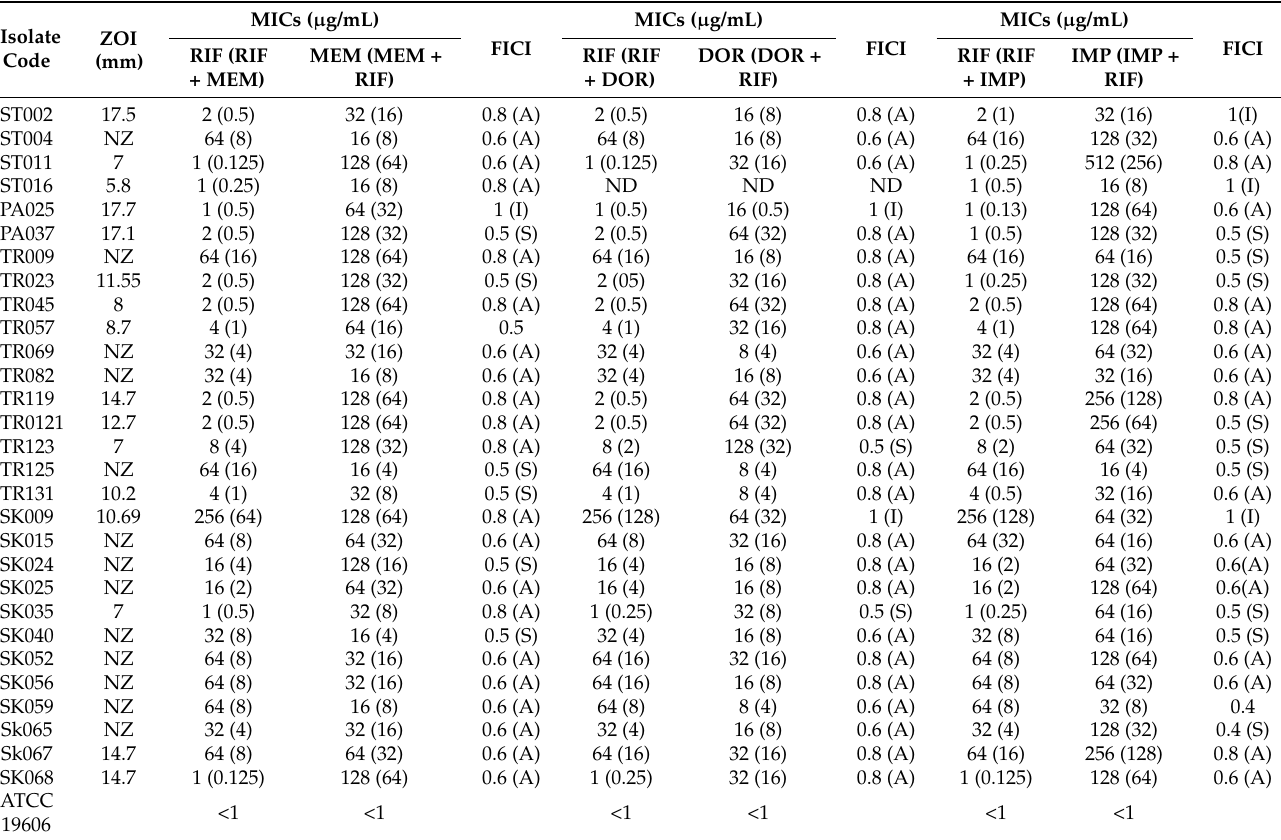
Table 1. Minimum inhibitory concentration (MIC) and combinatorial antibacterial activity of subin- hibitory concentration of carbapenems on carbapenem-resistant Acinetobacter baumannii